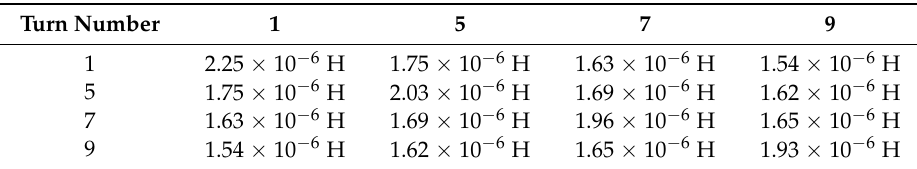
Table A1. A part of the inductance matrix at 100